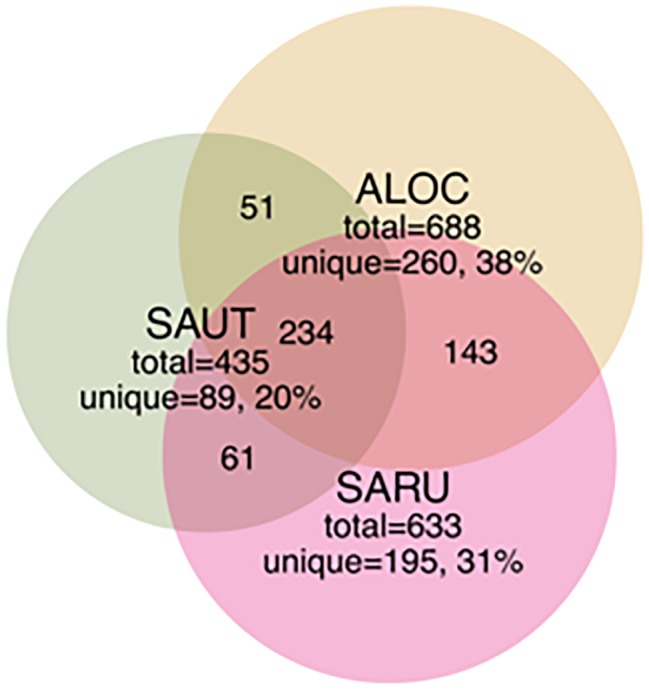
Venn diagrams showing the distribution of shared and unique rhizobacterial species between the three halophyte species. Recovery was based on OTUs from bacterial community libraries of the 16S rRNA gene (97% similarity cutoff), with numbers indicated in each quadrant (not to scale). Abbreviations are as in Figure 2.